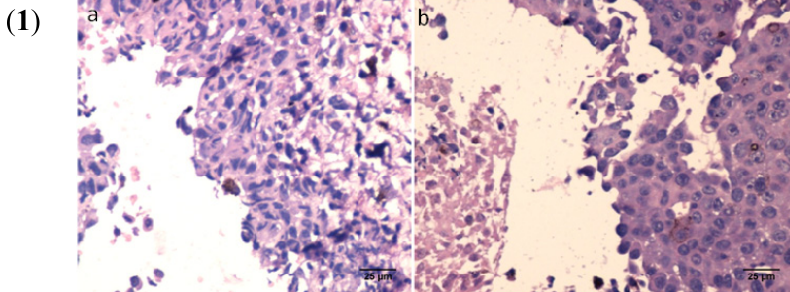
Figure 9. Histopathology of skin sections collected on day 21. ( 1 ) Group A (non-treated): ( a ) Tumor proliferation at the skin level characterized by the presence of elongated and oval cells with strong pleomorphism (HE ×400); and ( b ) Skin section with malignant melanoma detail with tumor necrosis (HE ×400). ( 2 ) BA complex-treated group: Tumor cells with vesicular nucleus, macronucleoli, atypical mitosis; ( a ) HE ×200; and ( b ) HE ×400. ( 1